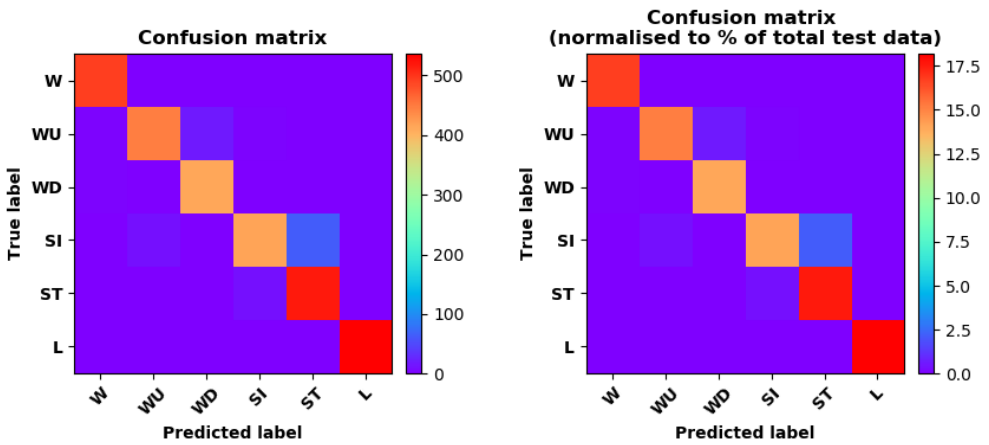
Figure 10. Left graph is the confusion matrix of classification test using the model trained by CNN network; right is the normalised confusion matrix.